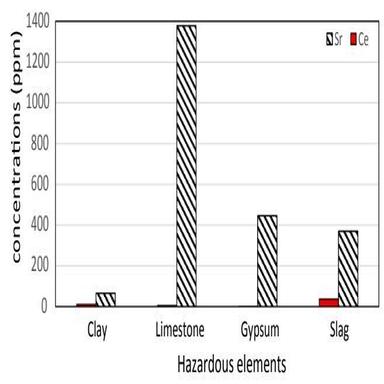
ICP plasma spectroscopy data concentrations of hazardous elements in different samples.